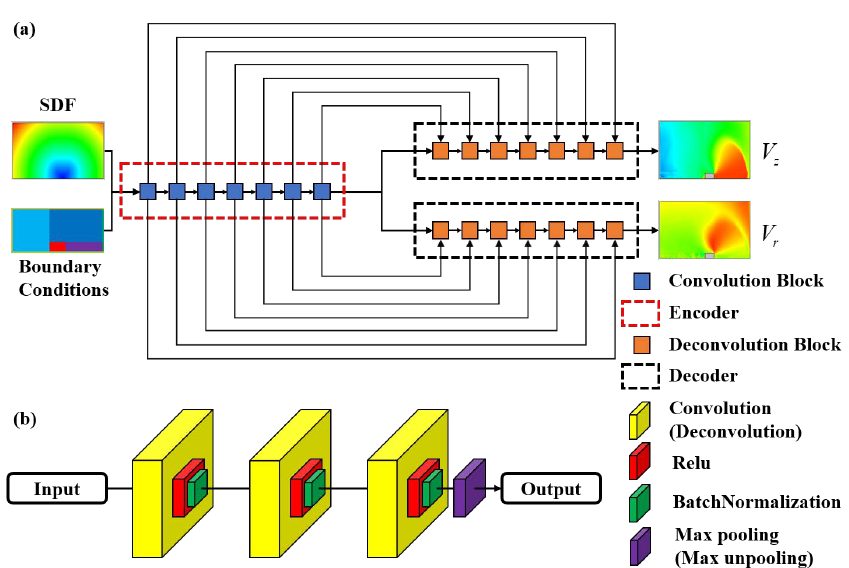
Figure 19. ( a ) Network architecture for CNN-DSMC in the prediction of vacuum plume. ( b ) Architec- ture of a single convolution (deconvolution) block [147].